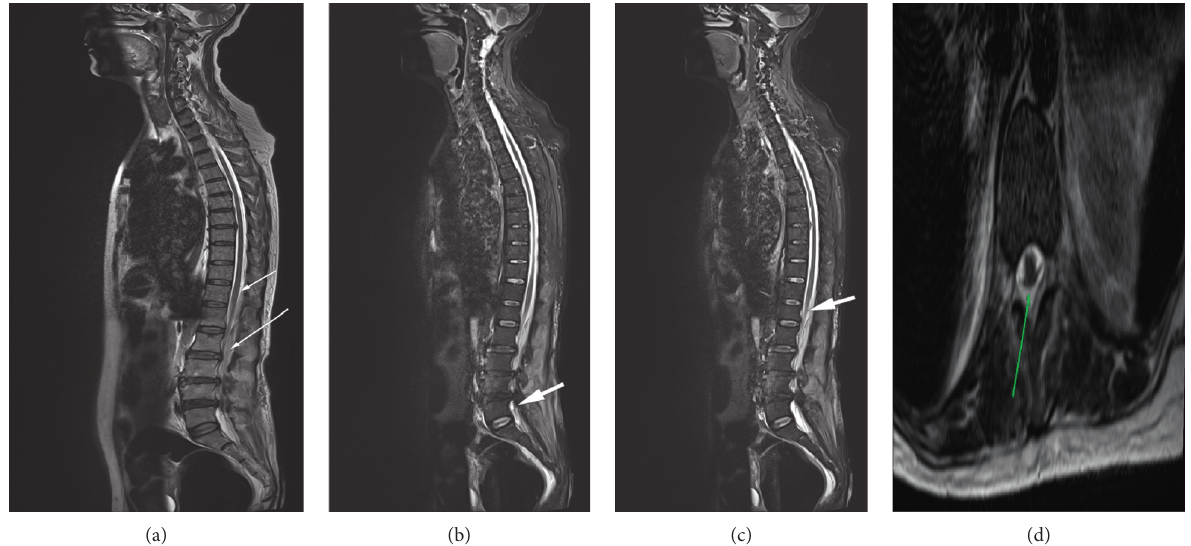
Figure 2: T2-weighted MRI of the spine from the cervical to lumbosacral region depicting a long-segment epidural abscess extending from T11-T12 to L5-S1. Size: 0.8cm (AP diameter) × 22.5cm (length) × 1.79cm (width). No pre- or paravertebral abscesses were visible. (a)-(c): sagittal views. (a): short white arrow- abscess seen commencing at the T12 level and long arrow- abscess extending downwards. (b) and (c): white arrows- abscess visible at L5 segment and the abscess causing cauda equina compression at the L1 level, respectively. (d): axial view; green arrow- abscess at the L4